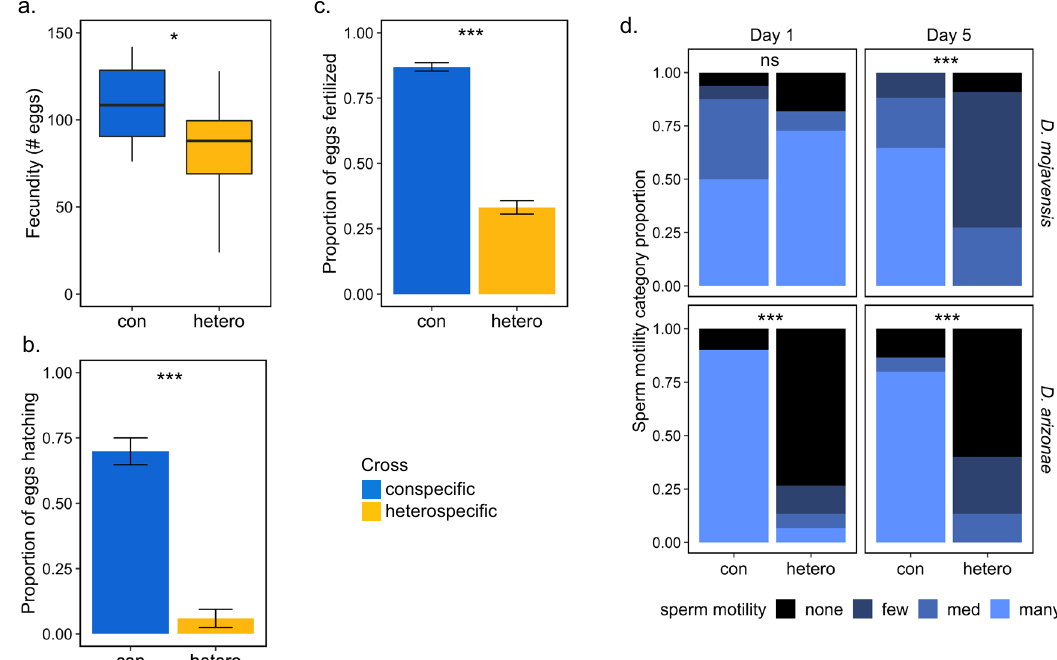
Fig. 1 Evidence of postmating-prezygotic isolation between D. mojavensis and D. arizonae . a Egg production over seven days of D. arizonae females following a con- or heterospeci fi c mating ( n = 10 and 11 females, respectively). b Proportion of eggs oviposited by D. arizonae females in a , that hatch into fi rst instar larva. c Proportion of eggs oviposited by D. arizonae females following a con- or heterospeci fi c mating that were determined to be fertilized using DAPI staining ( n = 445 and 338 eggs, respectively). These results indicate an overall decrease in reproductive success of heterospeci fi cally mated D. arizonae . d Levels of sperm motility within seminal receptacles in both D. mojavensis and D. arizonae females mated con- and heterospeci fi cally at 1 and 5 days postmating. P -values of correlations are noted: * P < 0.05, ** P < 0.01, *** P < 0.001, ns not signi fi cant ( P > 0.05). Boxplots represent the median with 25th and 75th percentiles, and whiskers show the 1.5 interquartile range. Bar graphs identify mean and standard error bars.